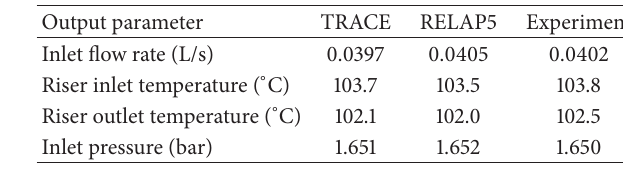
Table 3: Output parameters, test S-1.